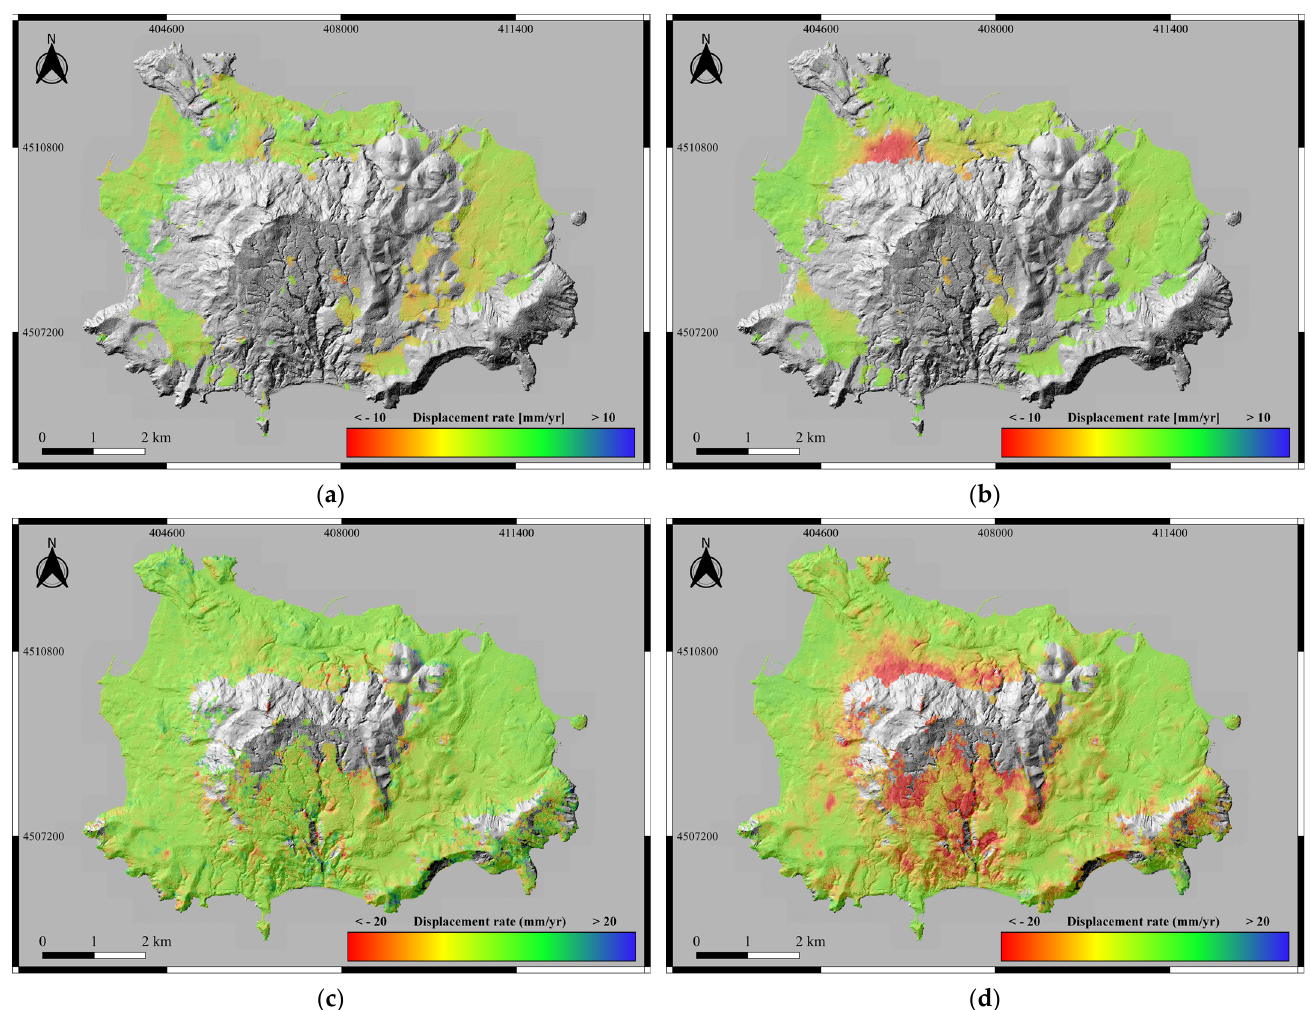
Figure 8. Horizontal ( a , c ) and vertical ( b , d ) displacement maps for Envisat ( a , b ) and Sentinel-1A ( c , d ) datasets.